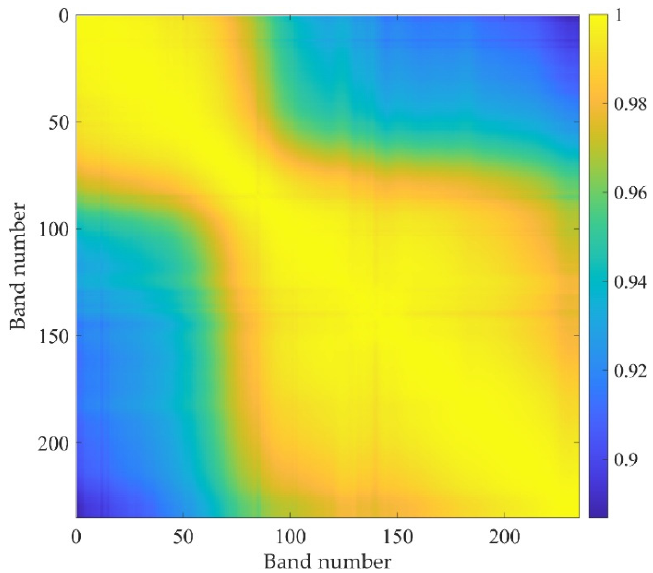
Figure 2. Correlation coefficients between the 235 bands.